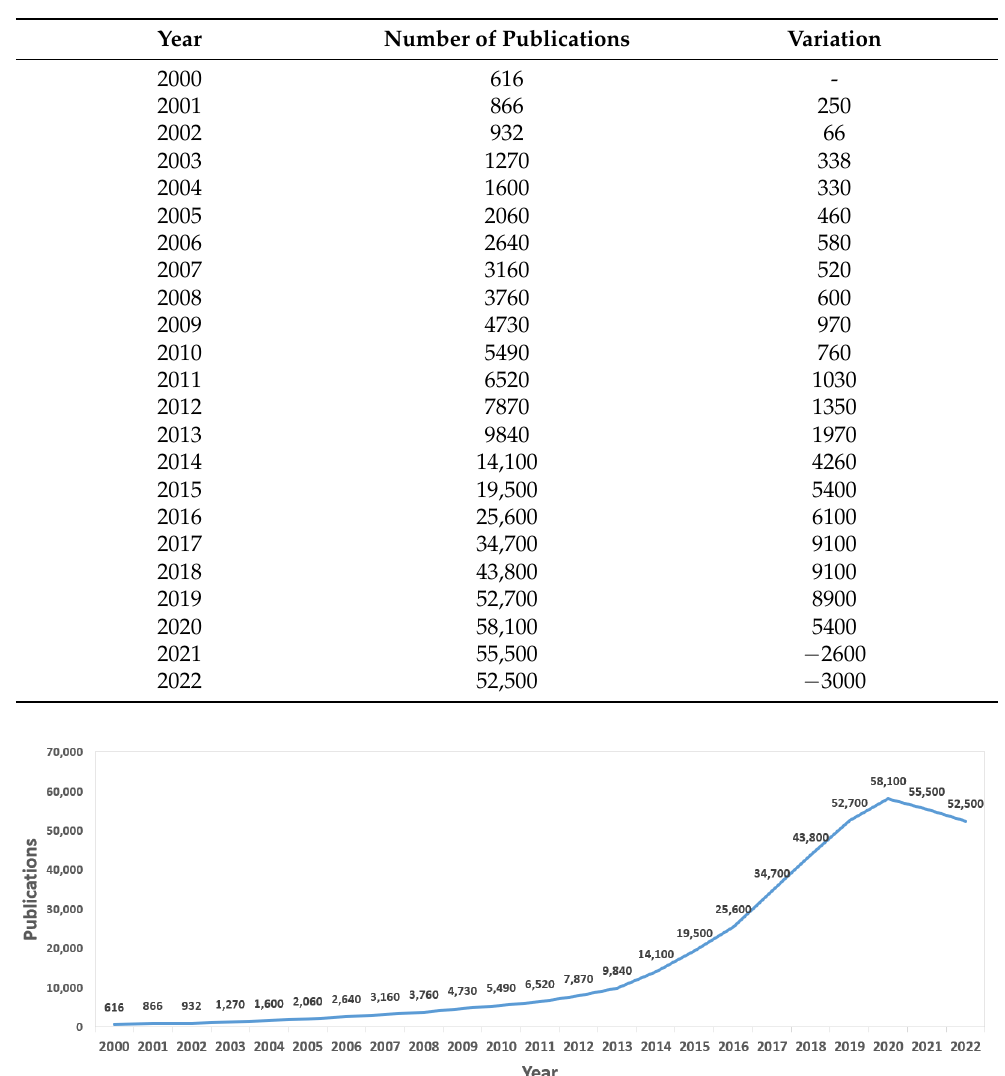
Table 1. Global evolution of journal publications.